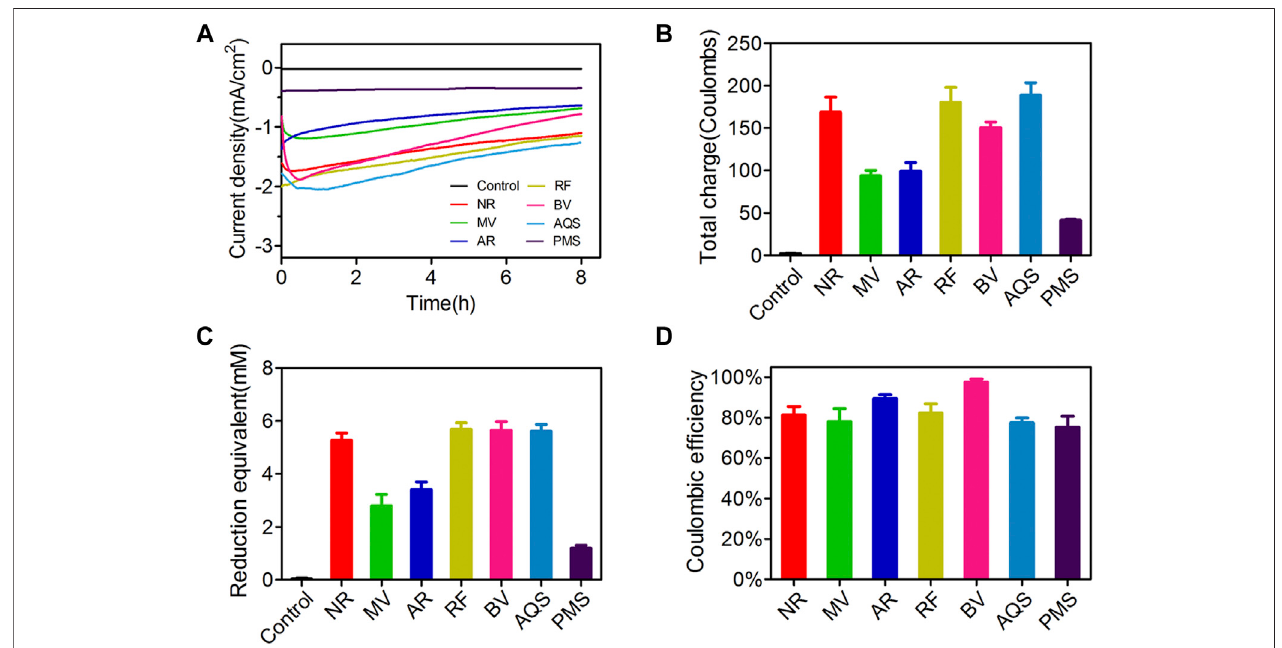
FIGURE 1 | The electrochemical properties of different ESs in MES. (A) Current produced by a cathode with or without ESs addition was recorded by the CHI1030C potentiostat under the potential of − 0.65 V (vs. Ag/AgCl). Current density was calculated using the cathodic surface area of carbon cloth. (B) Total charge production was determined in the end of 8-h electrosynthesis period. (C) The production of succinate was used as an important indicator of reduction product equivalent, which was examined by the HPLC method. (D) Coulombic ef fi ciency was calculated according to the equation in “ Materials and Methods ” section. Results are representative of at least two independent experiments performed in triplicate and are expressed as mean ± standard deviation